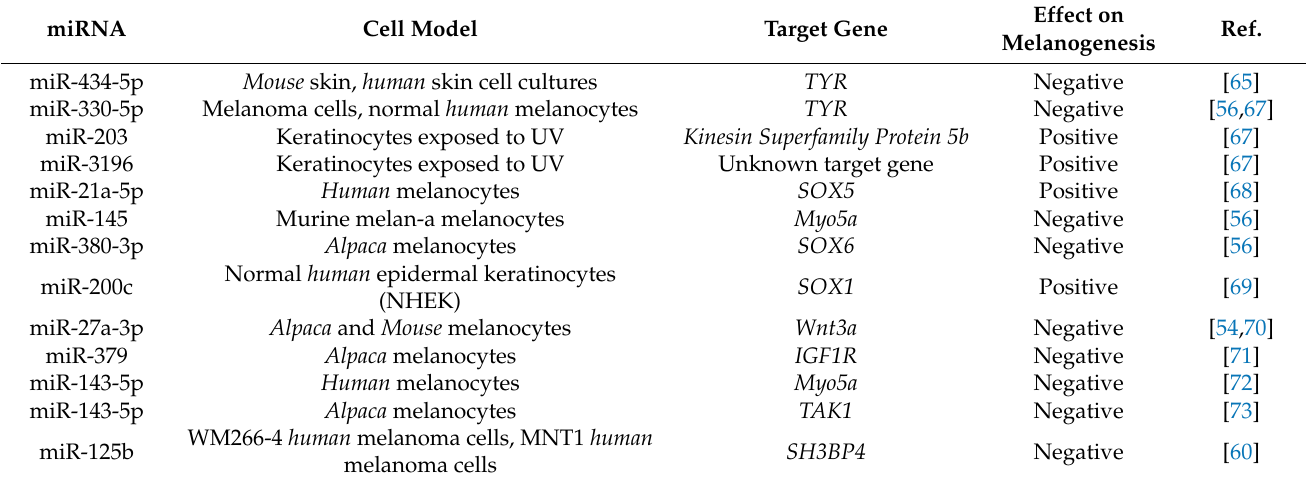
Table 2. Other microRNAs involved in